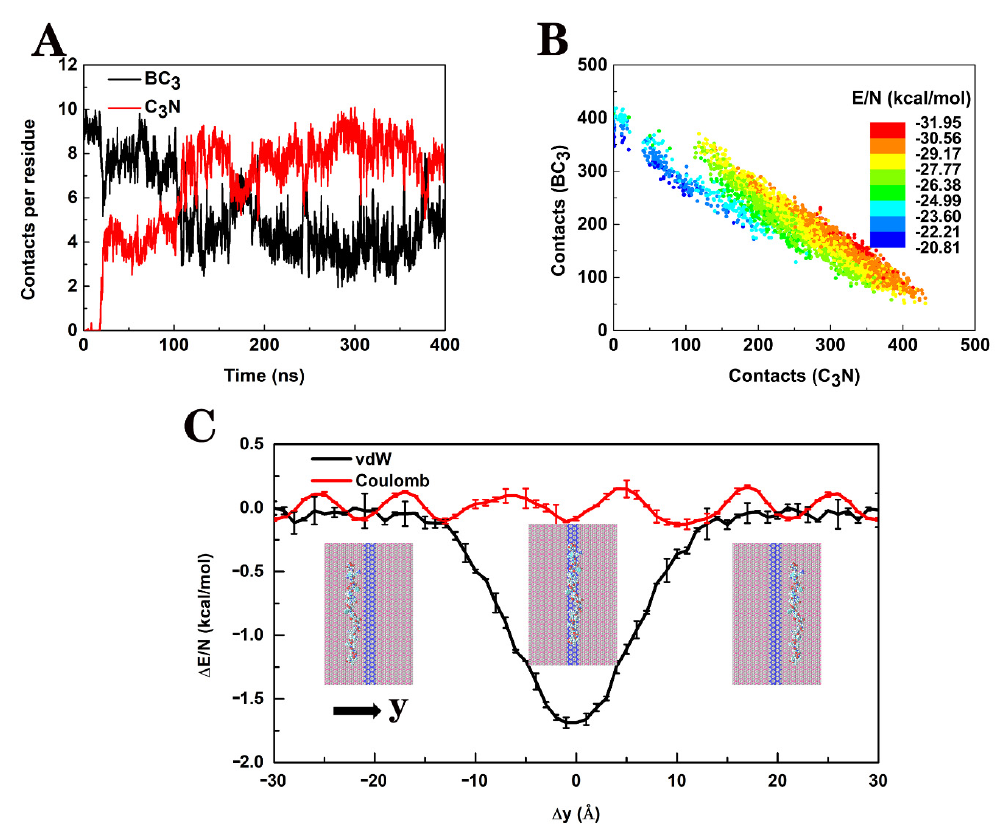
Figure 4. ( A ) Number of atoms in BC 3 /C 3 N/BC 3 that are within 4.0 Å of the A β peptide throughout the simulation. ( B ) A scatter plot of the number of atoms in BC 3 /C 3 N/BC 3 in contact with A β . The color represents the average interaction energy per residue between A β and BC 3 /C 3 N/BC 3 . ( C ) The average van der Waals (black line) and Coulomb (red line) interaction energy between A β and BC 3 /C 3 N/BC 3 with standard deviations, when the elongated A β peptide moved across the C 3 N band in the y-direction.